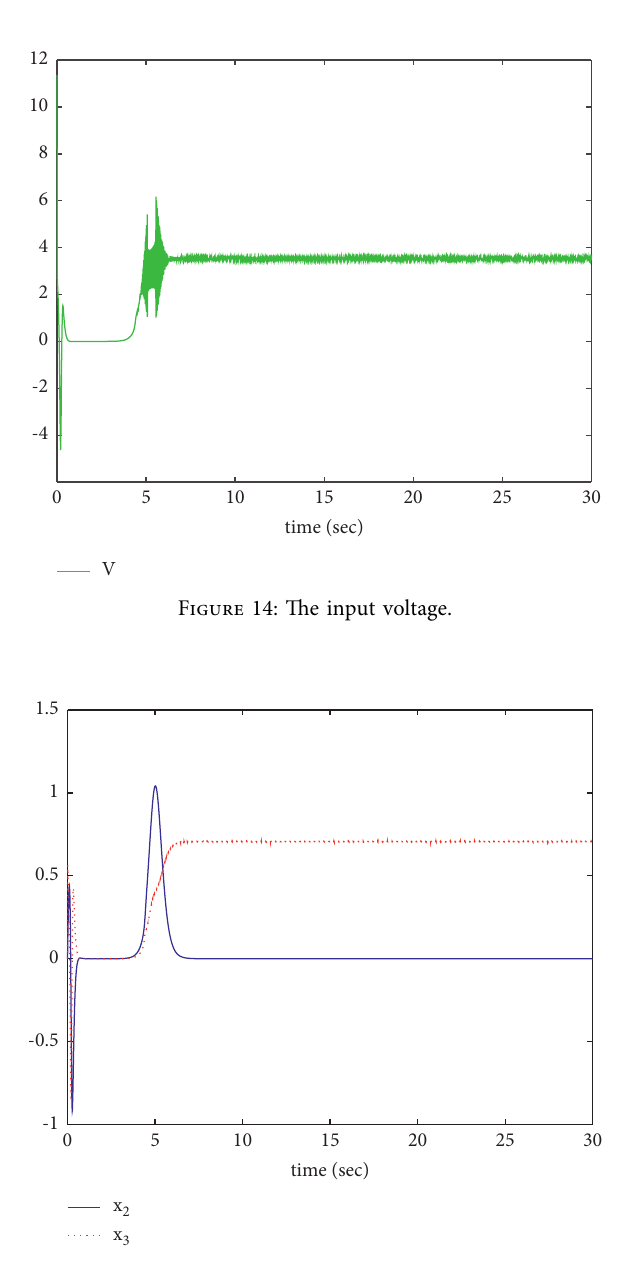
Figure 15: The angular velocity and motor